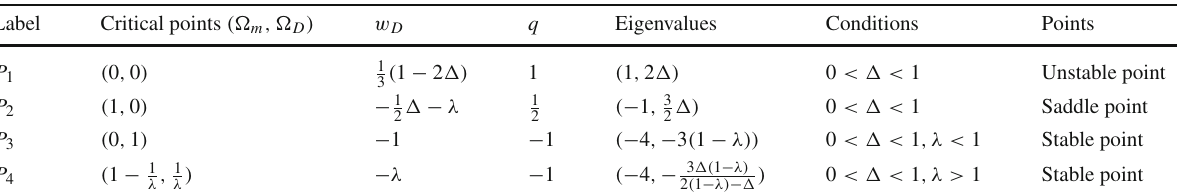
Fig. 22 Phase space trajectories for IBHDEHL with λ = − 0 . 5. The left panel is plotted for the behavior of attractor P 3 with (cid:5) = 0 . 8, the right panel is plotted for the evolution trajectories with different value of 0 < (cid:5) <